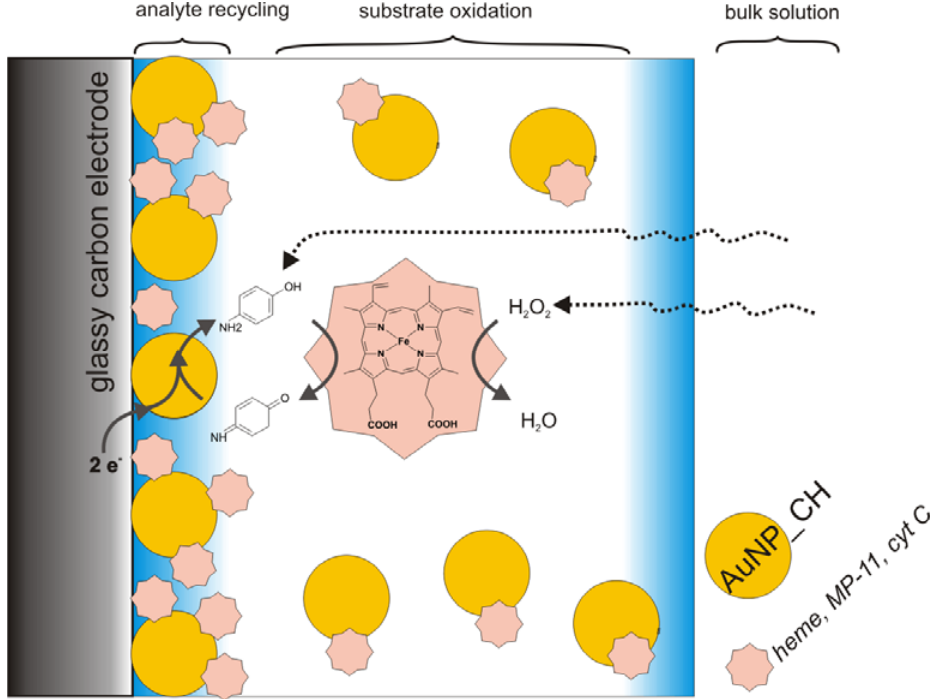
Figure 1. Schematic representation of the